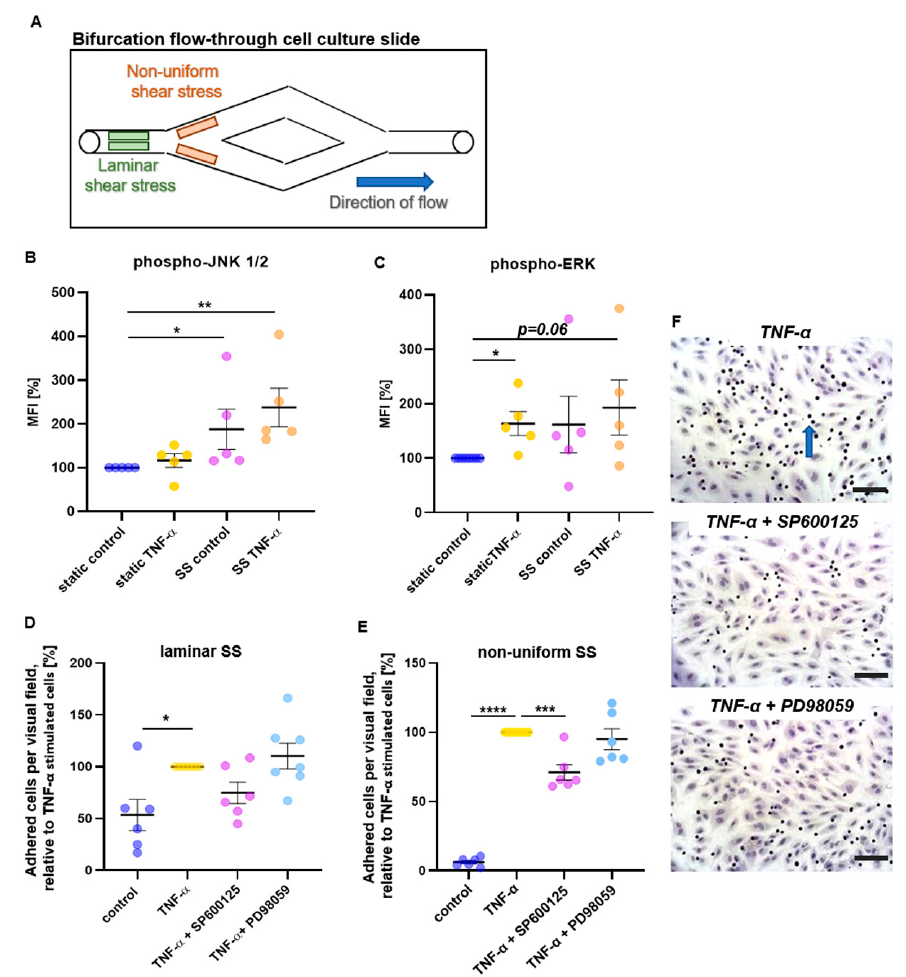
tions, exposure to SS increased phosphorylated JNK1/2 ( p = 0.0460), as well as additional inflammatory stimulation with TNF- α ( p = 0.0021) (Figure 1B).